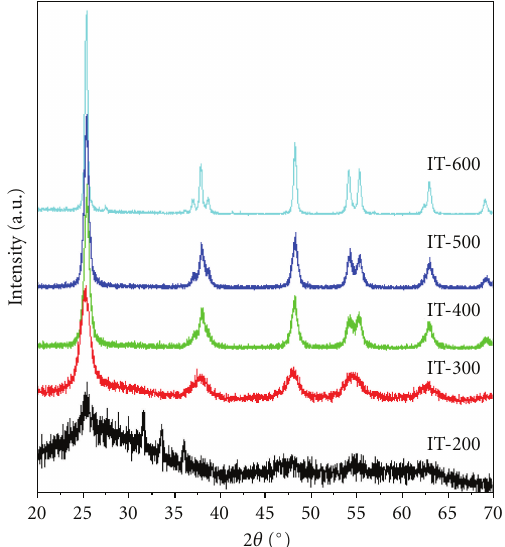
Figure 1: XRD patterns of the corresponding (I 2 ) n sensitized IT-T samples after calcinated at 200 ◦ C, 300 ◦ C, 400 ◦ C, 500 ◦ C, and 600 ◦ C.